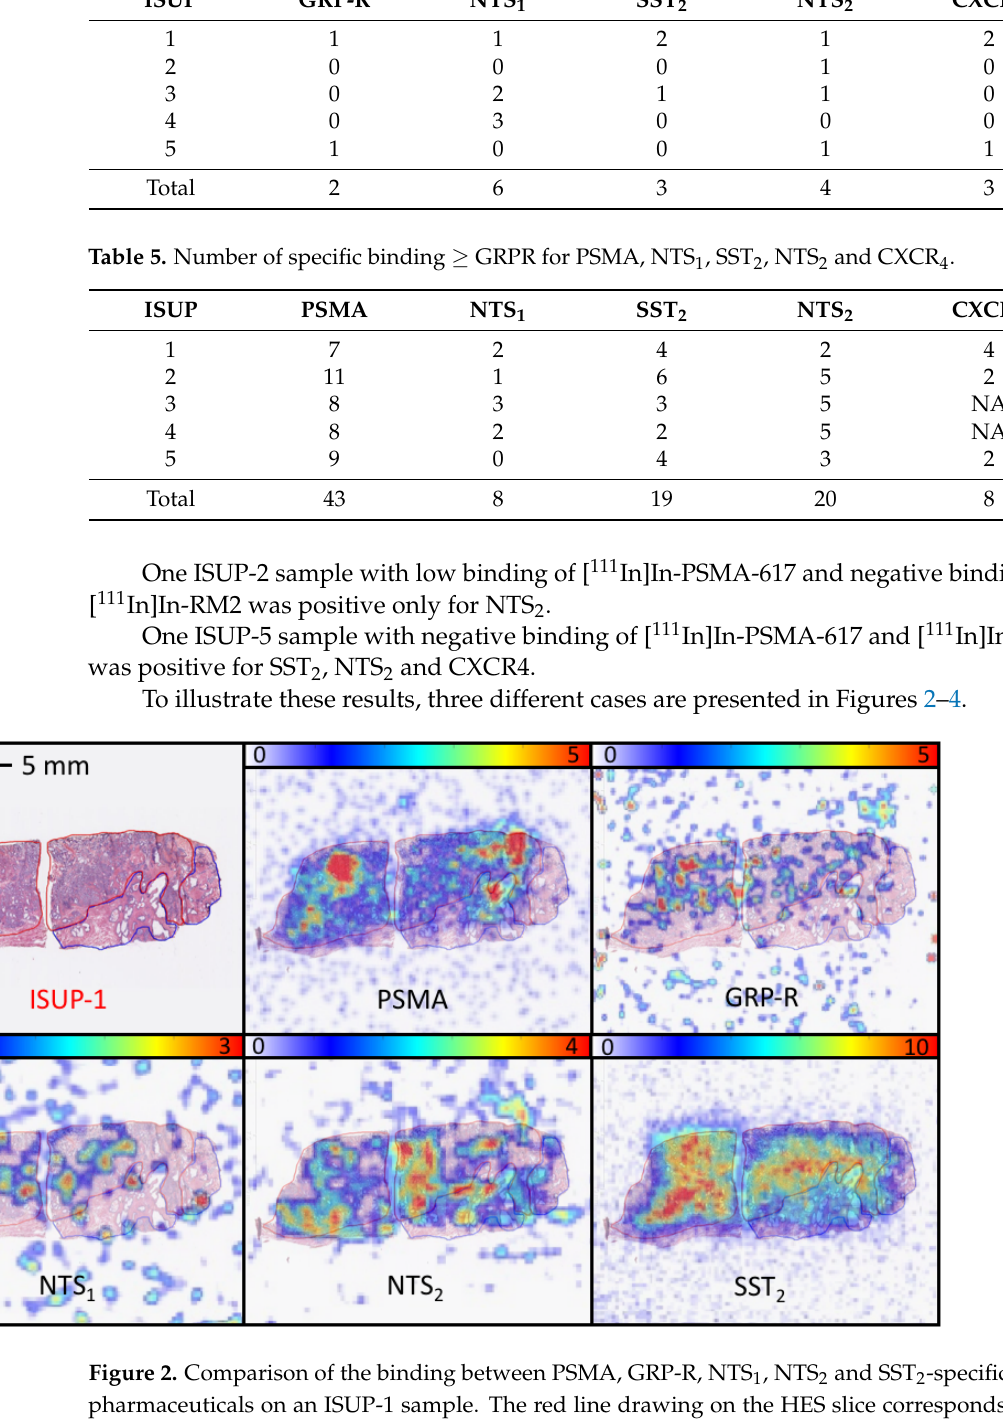
Figure 3. Comparison of the binding between PSMA, GRP-R, NTS 1 , NTS 2 and SST 2- speci fi c radio- pharmaceuticals on an ISUP-5 sample. The red line drawing on HES slice corresponds to the tumor area. Speci fi c binding = 45% for PSMA, 40% for NTS 1 , 95% for NTS 2 and 40% for SST 2 . Speci fi c bind- ing was not available for GRP-R due to technical issues. Color scale refers to cps/mm².